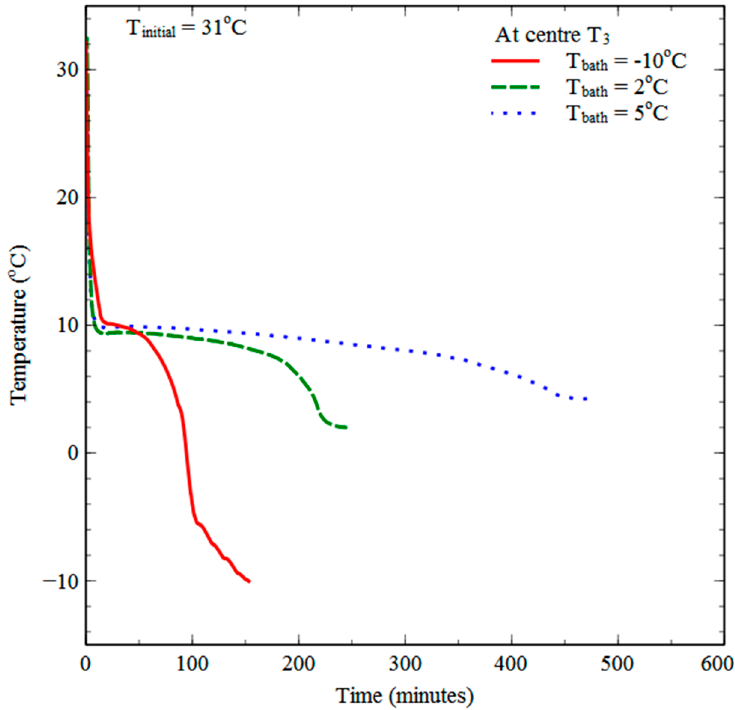
Figure 7. E ff ect of bath temperature on solidification of pure PCM at center (T 3 ) of the Figure 7. Effect of bath temperature on solidification of pure PCM at center (T 3 ) of the sphere.